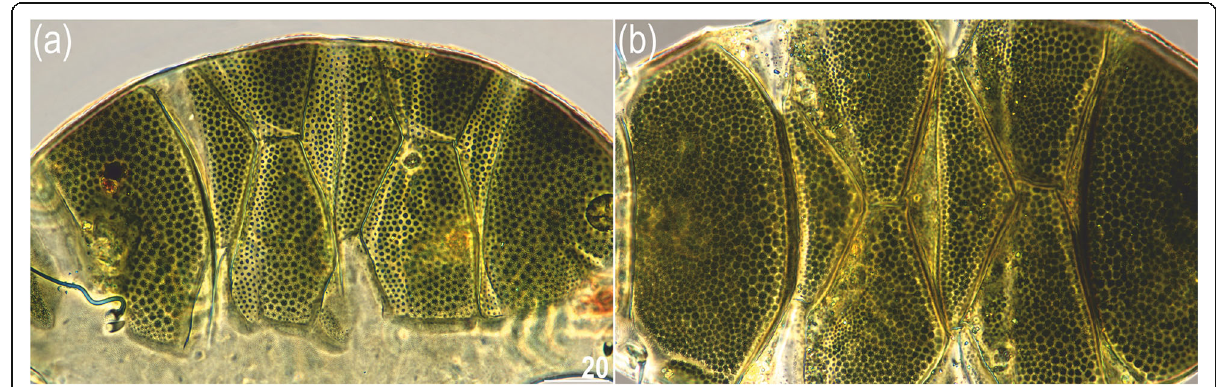
Fig. 1 Dorsal plate sculpturing of sexually mature females of (a) Viridiscus aff. viridianus from North America and (b) Viridiscus perviridis from Madeira. PCM photomicrographs; scale bars in μ m, both images in the same